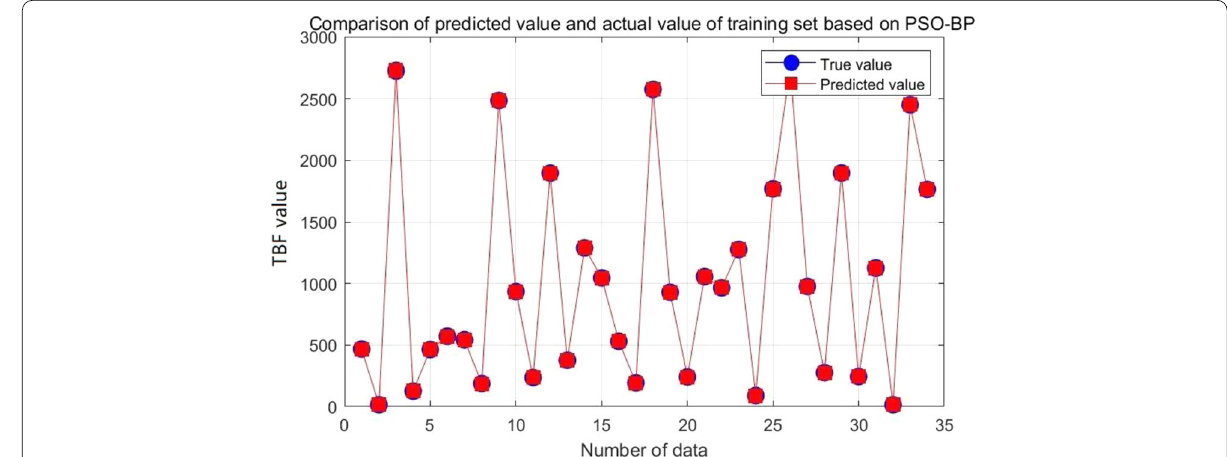
Figure 5 Comparison of the predicted value of the training sample with the true value